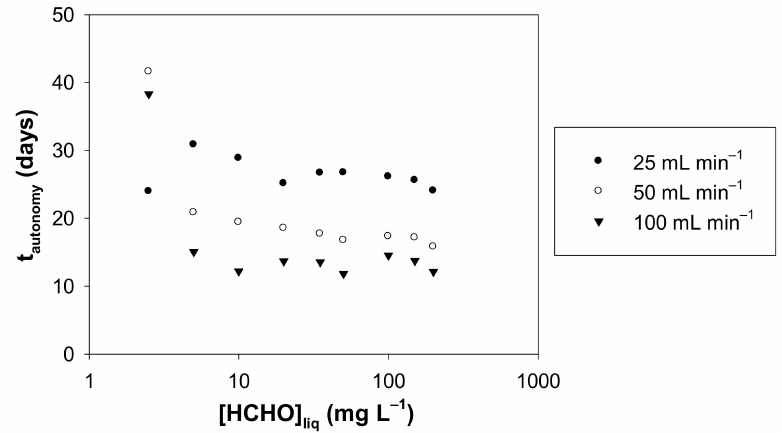
Figure 11. Autonomy (t autonomy ) vs. liquid formaldehyde concentration for a gas flow rate of 25, 50 and 100 mL min − 1 . The autonomy (t autonomy ) is the time required for a loss of 1% of the mole number present in the formaldehyde solution at 10 ◦ C, with a volume of liquid solution of 300 mL and for liquid formaldehyde concentration in the range 2.5–200 mg L − 1